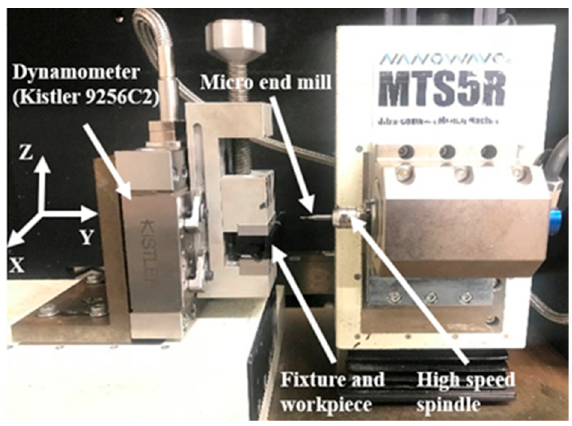
Figure 6. Setup for the milling process and cutting force measurement.